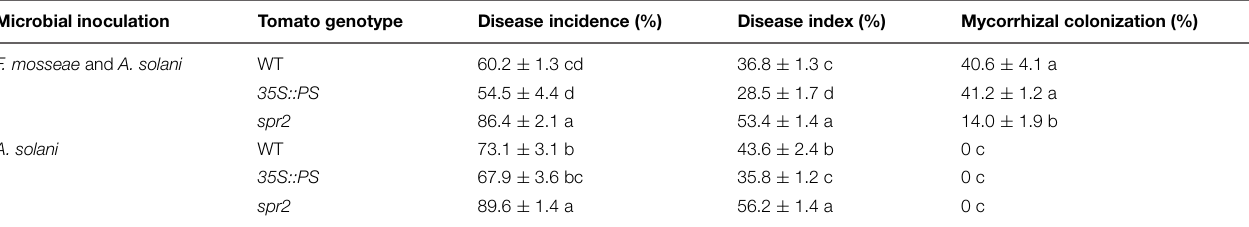
TABLE 3 | Mycorrhizal colonization rates, disease incidences, and indices of AMF-inoculated and un-inoculated tomato plants inoculated by AMF Funneliformis mosseae and pathogen A. solani. Microbial inoculation Tomato genotype Disease incidence (%) Disease index (%) Mycorrhizal colonization (%) F. mosseae and A.